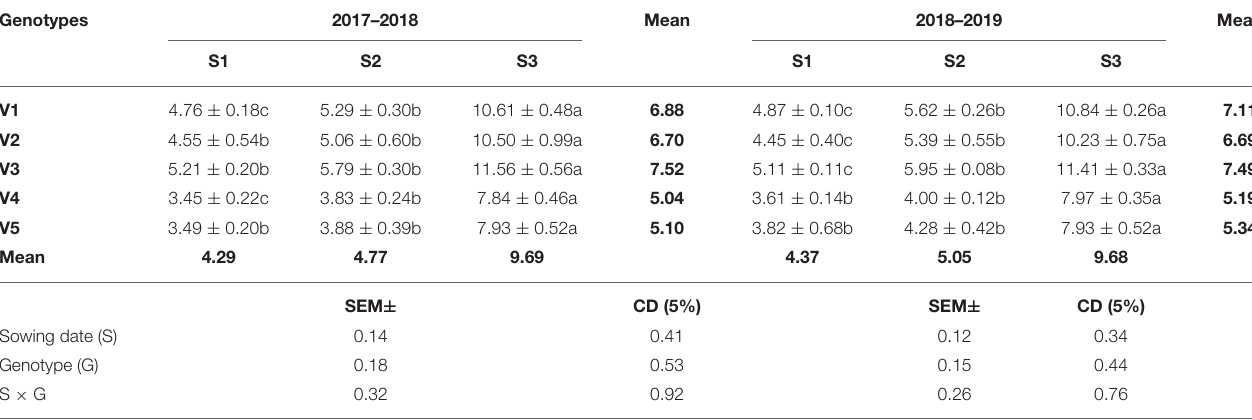
TABLE 5 | The SOD activity (EU mg − 1 protein min − 1 ) at mid-flowering stage in the top leaf of mustard varieties sown at three different dates during rabi 2017–2018 and 2018–2019. Genotypes